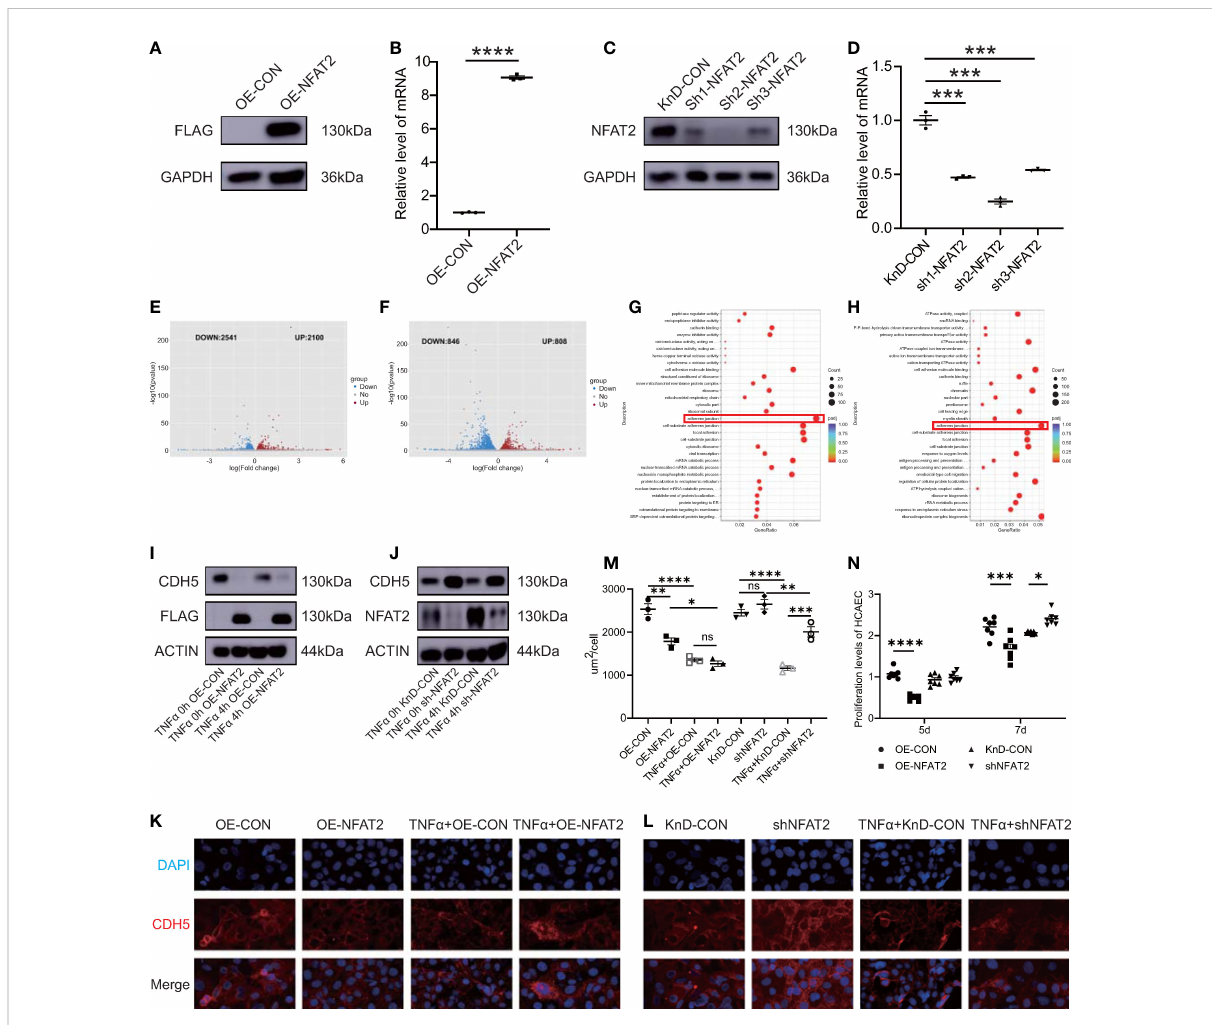
FIGURE 2 NFAT2 disrupted endothelial cell homeostasis. (A, B) At 7 days after transfection of NFAT2 overexpressing lentiviruses ((OE-NFAT2) and their corresponding control (OE-CON), (A) NFAT2 protein levels were assayed using western blotting, with a loading control comprising GAPDH, and (B) NFAT2 mRNA expression was assessed using qRT-PCR (n = 3). (C, D) At 7 days after transfection of lentiviruses for the knockdown NFAT2 (sh1~sh3) and its corresponding controls (KnD-CON), (C) western blotting was used to assess NFAT2 protein levels, with a loading control comprising GAPDH, and (D) NFAT2 mRNA expression was assessed using qRT-PCR (n = 3). (E, F) Volcano plot showing differentially expressed genes (DEGs) in response to NFAT2 overexpression (E) or NFAT2 knockdown (F) . Red dots represent upregulated genes; and blue dots represent downregulated genes. Gene Ontology (GO) functional enrichment analysis of DEGs related to NFAT2 overexpression (G) and NFAT2 knockdown (H) . (I) HCAECs transfected with NFAT2 overexpressing lentiviruses (OE-NFAT2) and their corresponding control (OE-CON) were stimulated with/without TNF a (40 ng/ml) for 4 hours. CDH5 and NFAT2 protein levels were analyzed. b -Actin served as a loading control. (J) HCAECs transfected with NFAT2 knockdown lentiviruses (shNFAT2) and their corresponding control (KnD-CON) were stimulated with/without TNF a (40 ng/ml) for 4 hours. CDH5 and NFAT2 protein levels were analyzed as described. b -Actin served as a loading control. (K – M) The expression of CDH5 was detected by immuno fl uorescence. NFAT2 overexpression (K) and knockdown (L) vectors and their corresponding controls were transfected into HCAECs, respectively. After 7 days, cells were stimulated with/without TNF a (40 ng/ml) for 4 hours. The cells were immunostained with rabbit anti-CDH5, followed by staining with 594 goat anti-rabbit IgG (red). Cell nuclei were stained with DAPI (blue). The fl uorescent images were captured (K) . The immuno fl uorescence area per cell in the different groups is shown (M) (n = 3). (N) HCAECs were transfected with NFAT2 overexpression and knockdown vectors and their corresponding controls. After 5 days and 7 days, the proliferation of HCAECs were detected using a CCK8 assay (n = 7). Data are presented as the mean ± SEM. Quantitative data were analyzed using an unpaired t test (two-tailed) (B, D) and one-way ANOVA (M, N) , *P < 0.05, **P < 0.01, ***P < 0.001, ****P <